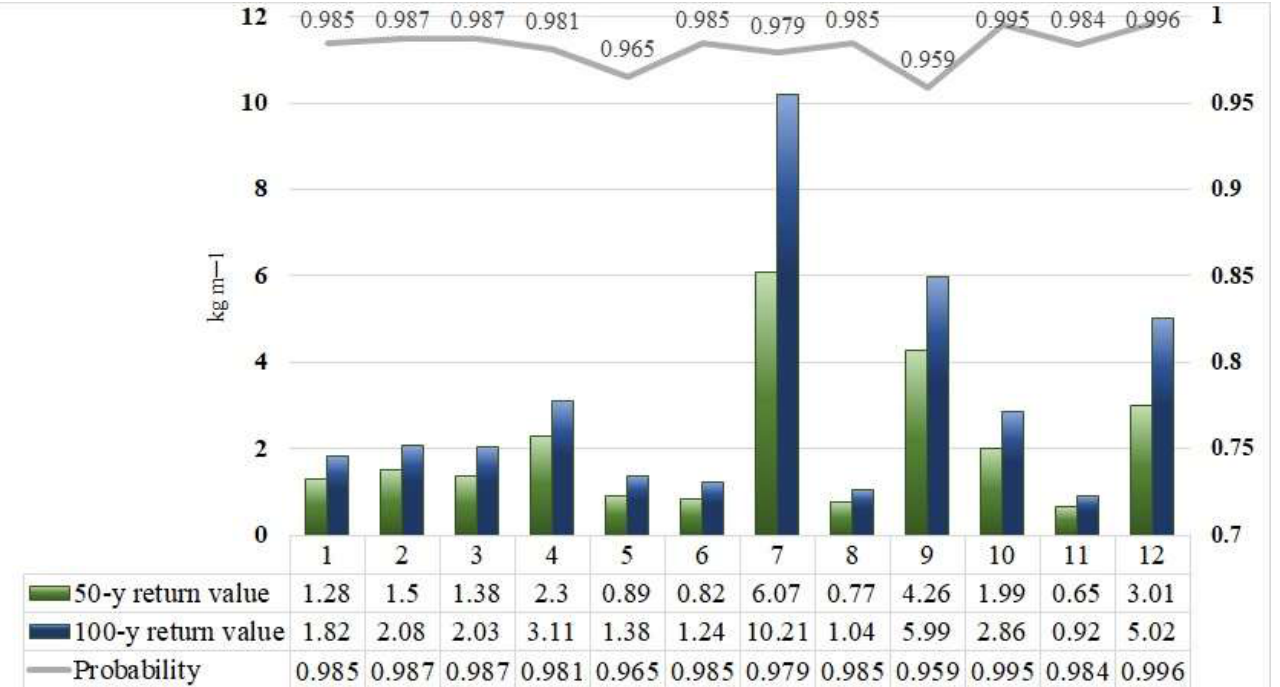
Figure 10. 50-year and 100-year return value of wet snow mass (kg·m −1 ) and the probability of the 50-year return value calculated from the estimated wet snow mass (kg·m −1 ) between 1991–2016. See the explanation of station labels 1–12 in Table 1.